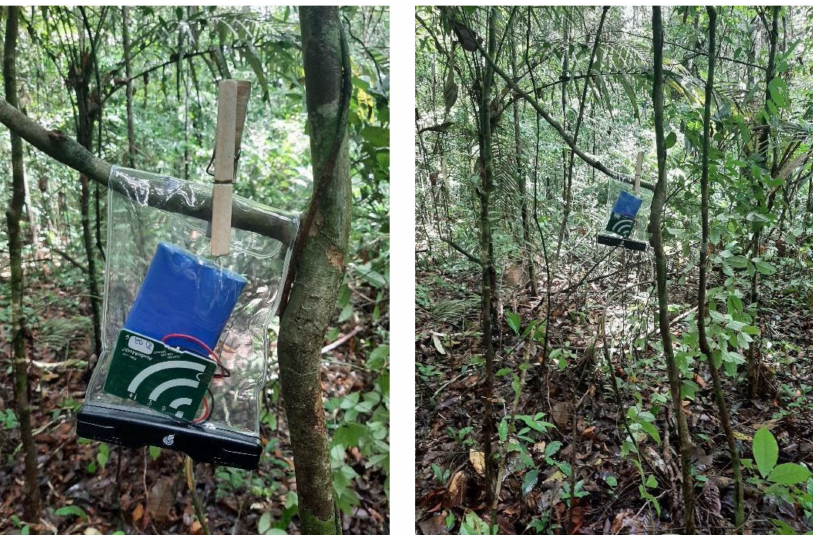
Figure A2. The AudioMoth device, an open acoustic, lightweight, and affordable autonomous recording unit used to monitor the soundscape in Puerto Rico during 2021. The device hardware, which included a lithium-ion rechargeable battery (blue packet in the photo), was placed in a protective waterproof plastic case with a silica packet and then deployed in a tree/vine/shrub at a 1.5 m height.